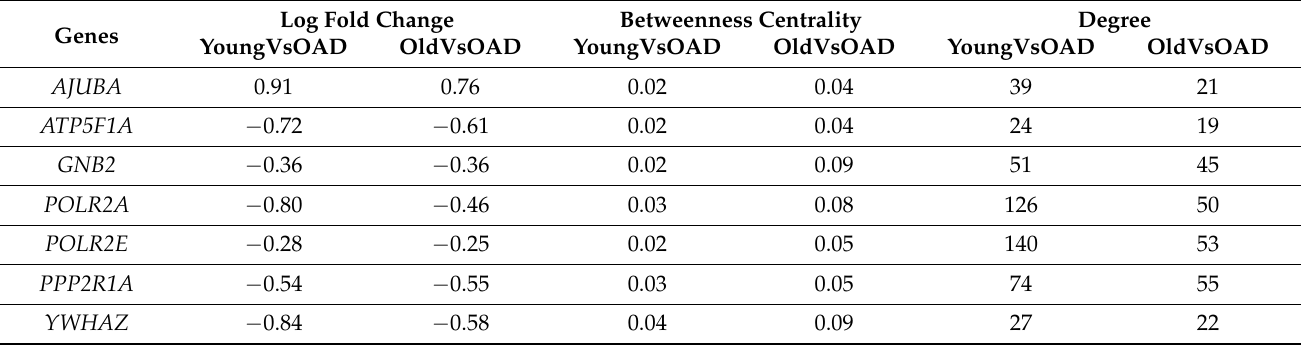
Table 3. DEGs with betweenness centrality outside the 97.5% distribution in both networks.